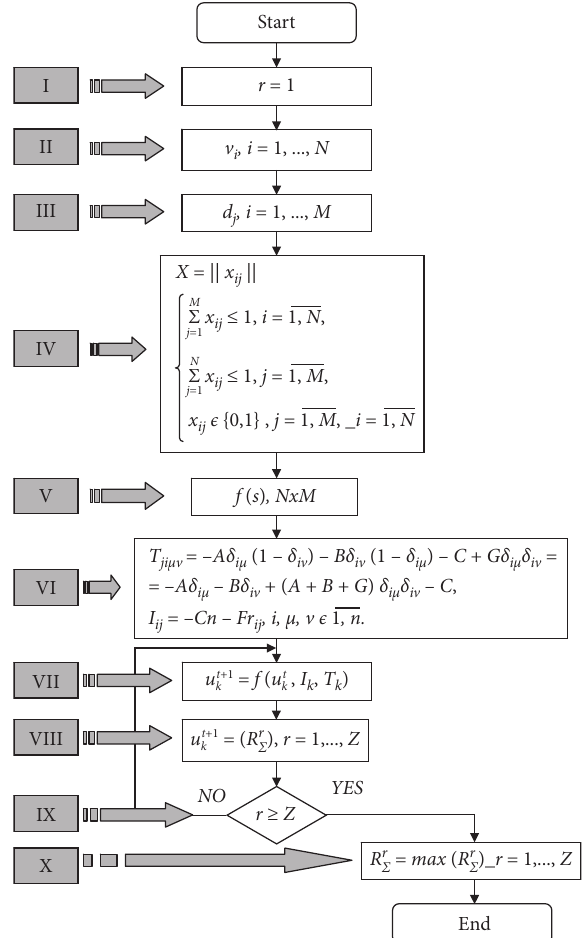
Figure 8: Block diagram of the neural network ranking algorithm with the vector relevance